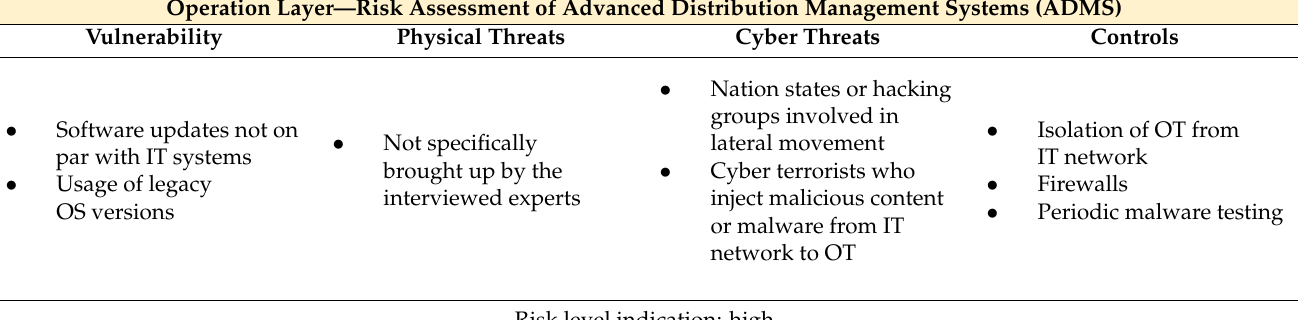
Table 13. Risk assessment of Advanced Distribution Management Systems (ADMS).